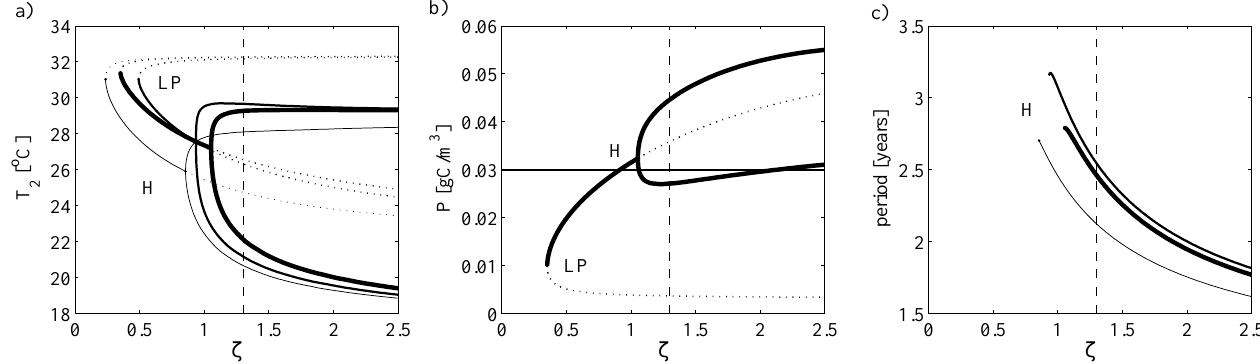
Fig. 5. (a) Eastern SST T 2 , (b) phytoplankton P, and (c) ENSO period as a function of the upwelling efficiency ζ in the fully coupled model (bold curves, k c = 0 . 74m 2 (gC) − 1 ) compared to a run without biology (thin curves, k c = 0), and a run of the physical model with constant background phytoplankton concentration P = 0 . 03gCm − 3 and k c = 0 . 74m 2 (gC) − 1 (medium width); H: supercritical Hopf bifurcation; LP: limit point; solid lines: minimum and maximum of stable oscillation or stable steady state respectively; dotted lines: unstable steady state.